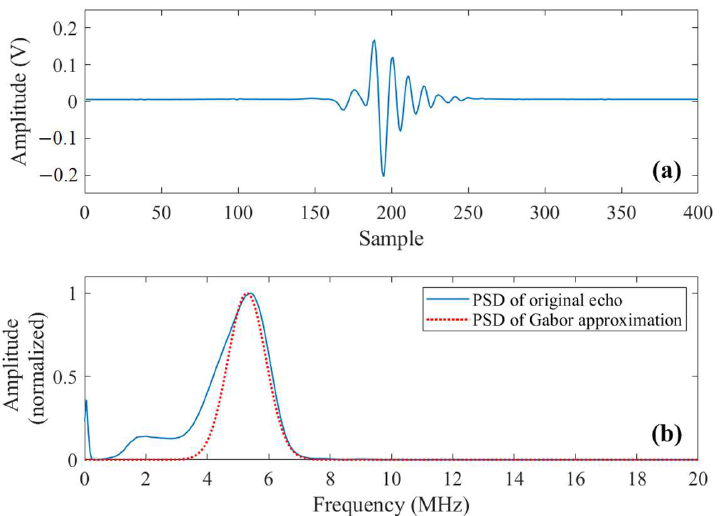
Figure 8. ( a ) The measured pulse transmitted by the transducer. ( b ) Frequency spectrum (F.S.) of the transmitted pulse and its Gaussian fitting. transmitted pulse and its Gaussian